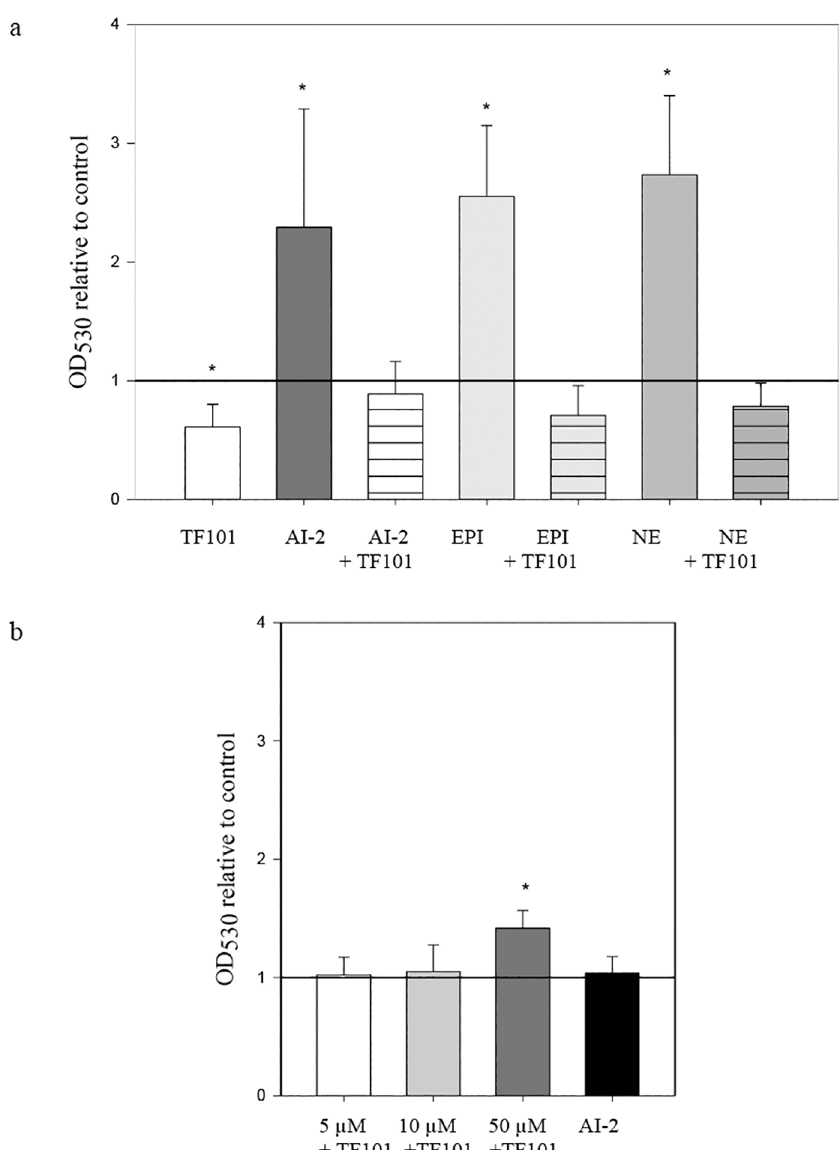
Fig 5. Biofilm formation. (a) Relative effect of TF101, AI-2, epinephrine (EPI) or norepinephrine (NE) on biofilm formation by E . coli O103:H2. 10 μ M TF101, 10 μ M AI-2, 10 μ M AI-2 + 10 μ M TF101, 50 μ M EPI, 50 μ M EPI + 10 μ M TF101, 50 μ M NE, or 50 μ M NE + 10 μ M TF101 was added during the biofilm assay. The effect of the different chemicals is presented as relative to control value (reference line (= 1)). The data are presented as mean values ± SD (n = 10). * Significantly different from control ( P < 0.05). (b) Relative effect of TF101 or AI-2 on biofilm formation by E. coli ABU 83972 ( lsr - ). In E . coli ABU83972, neither TF101 nor AI-2 affected biofilm formation, except at 50 μ M TF101 which gave a significant increase. The effect of TF101 or AI-2 on biofilm formation is presented as relative to control (= 1 reference line). The data are presented as mean values ± SD (n = 10). * Significantly different from control ( P <